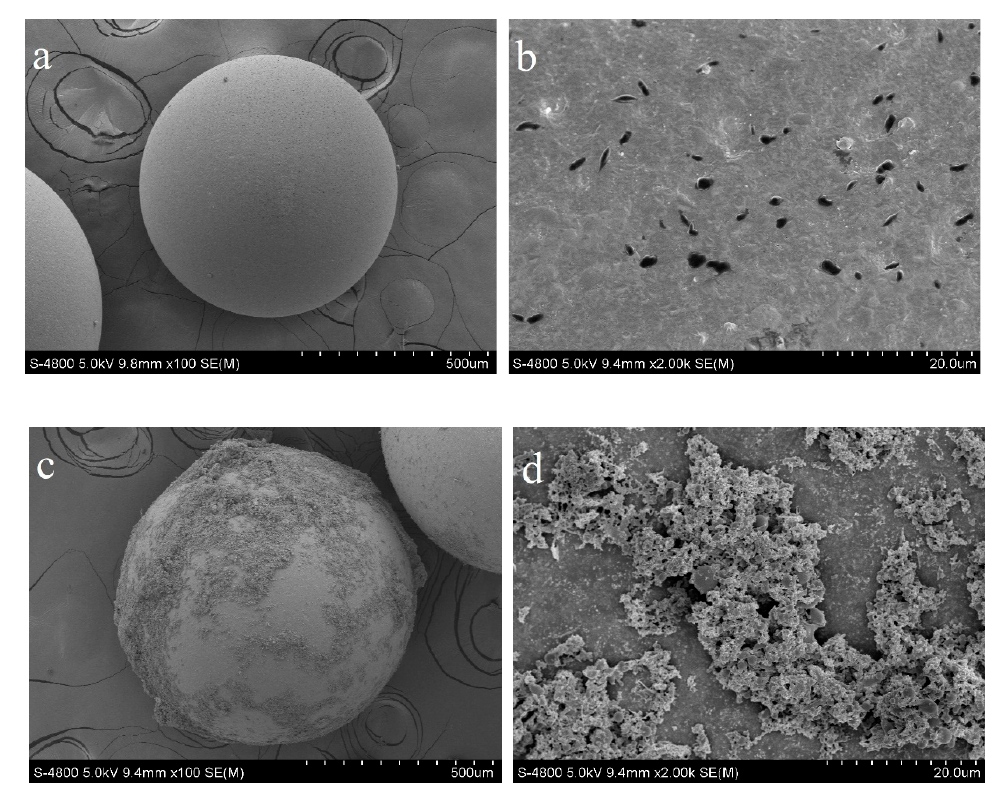
Figure 3. SEM images of the microsphere surface of chloromethyl polystyrene (CPS) ( a , b ) and SLPS ( c , d ).